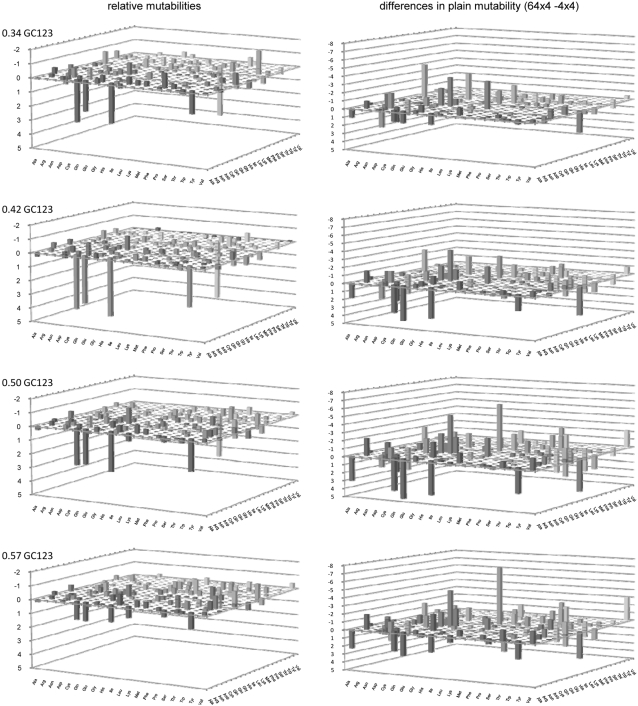
The expected incidence of amino-acid replacements due to one-base codon mutations in human coding regions, under 64×4 relative to 4×4 intronic mutation.Results from top to bottom are for 0.34, 0.42, 0.50, and 0.57 GC123 (i.e., points 2, 8, 14, and 17 from the left in Fig. 34). A positive value on the left indicates that the 64×4 mutability is (value +1.0)-fold higher than it 4×4 counterpart (1.0 was substracted to obtain 0.0 when two rates are identical); and a negative value indicates that the 4×4 value is abs(value −1.0)-fold higher than its 64×4 counterpart. On the right are the differences between each plain replacement mutability under 64×4 mutation and its 4×4 counterpart, to highlight the replacement dominating the patterns in Figure 34. Values on the right were rescaled to make the largest positive difference equal to 5.0 (i.e., the 245.7 Arg –>Gln rate). Therefore, values above the 0.0-plane, both left and right, indicate an advantage for NBDM (i.e., a 64×4 mutability lower than its 4×4 counterpart). Numeric values are shown in Figure 36.